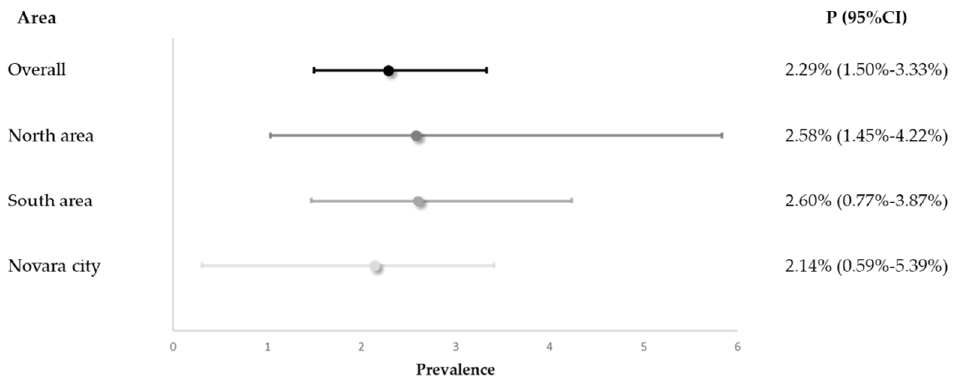
Figure 2. Prevalence of antibiotic use (P) and exact 95% confidence intervals (95%CI), overall and by district.